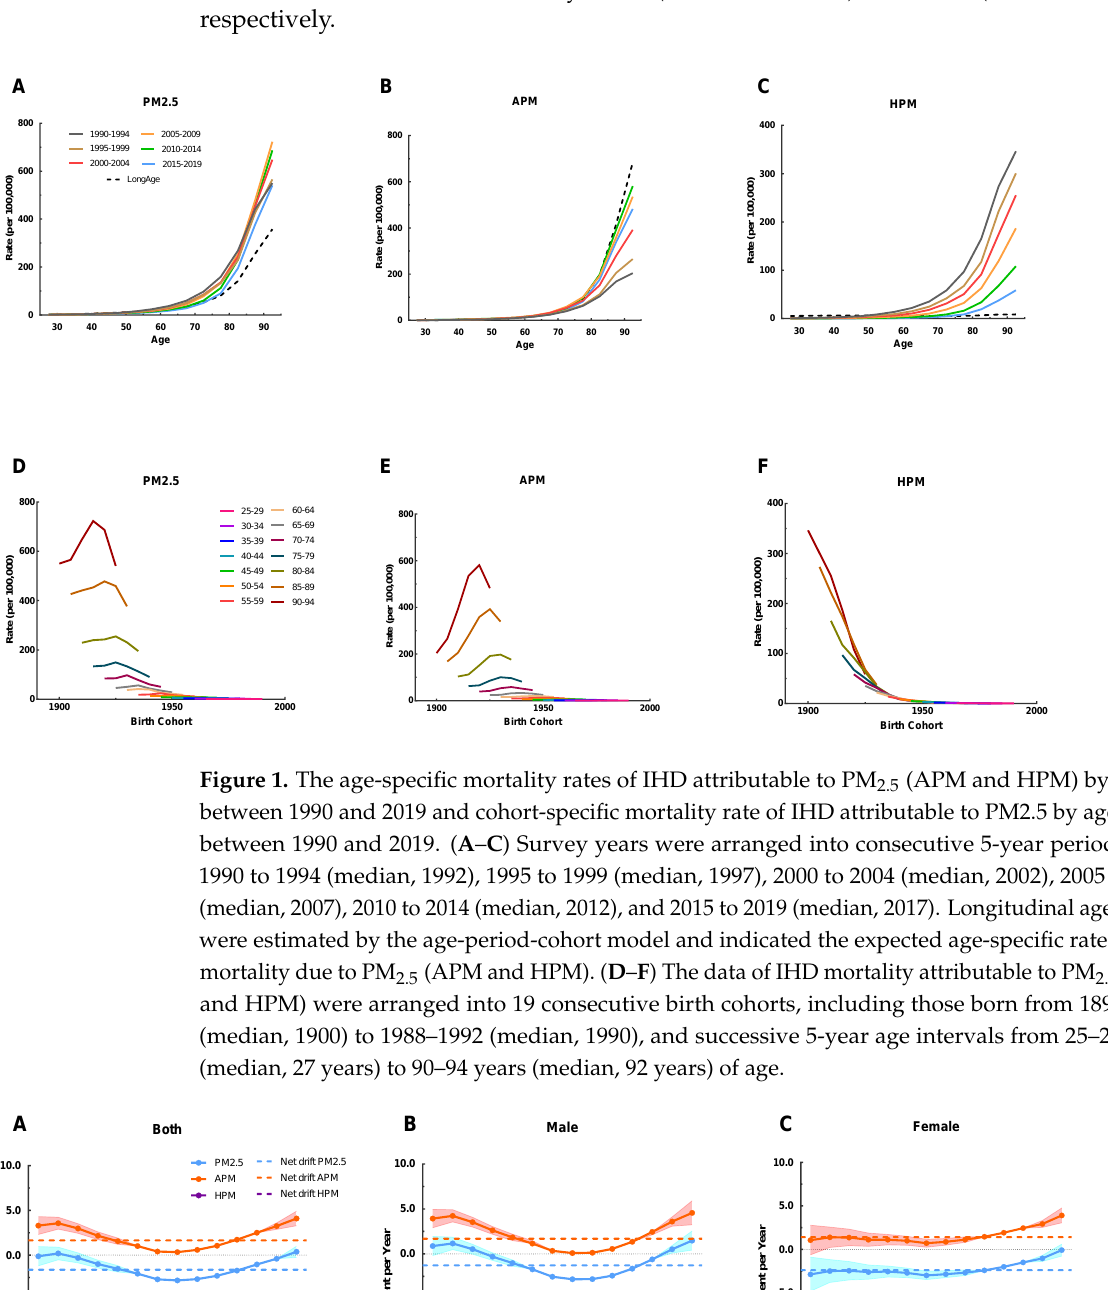
both men and women increased by 1.69% (95%CI: 1.51~1.87) and 1.42% (95%CI: 1.15~1.70),